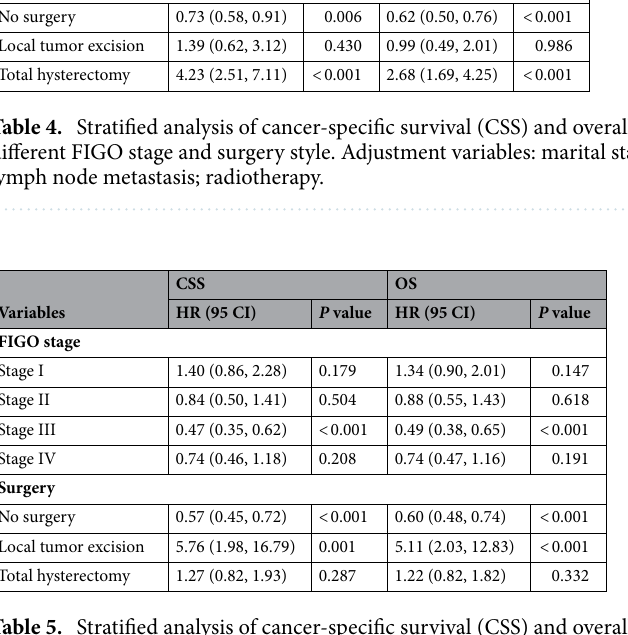
Table 5. Stratified analysis of cancer-specific survival (CSS) and overall survival (OS) for radiotherapy in different FIGO stage and surgery style.